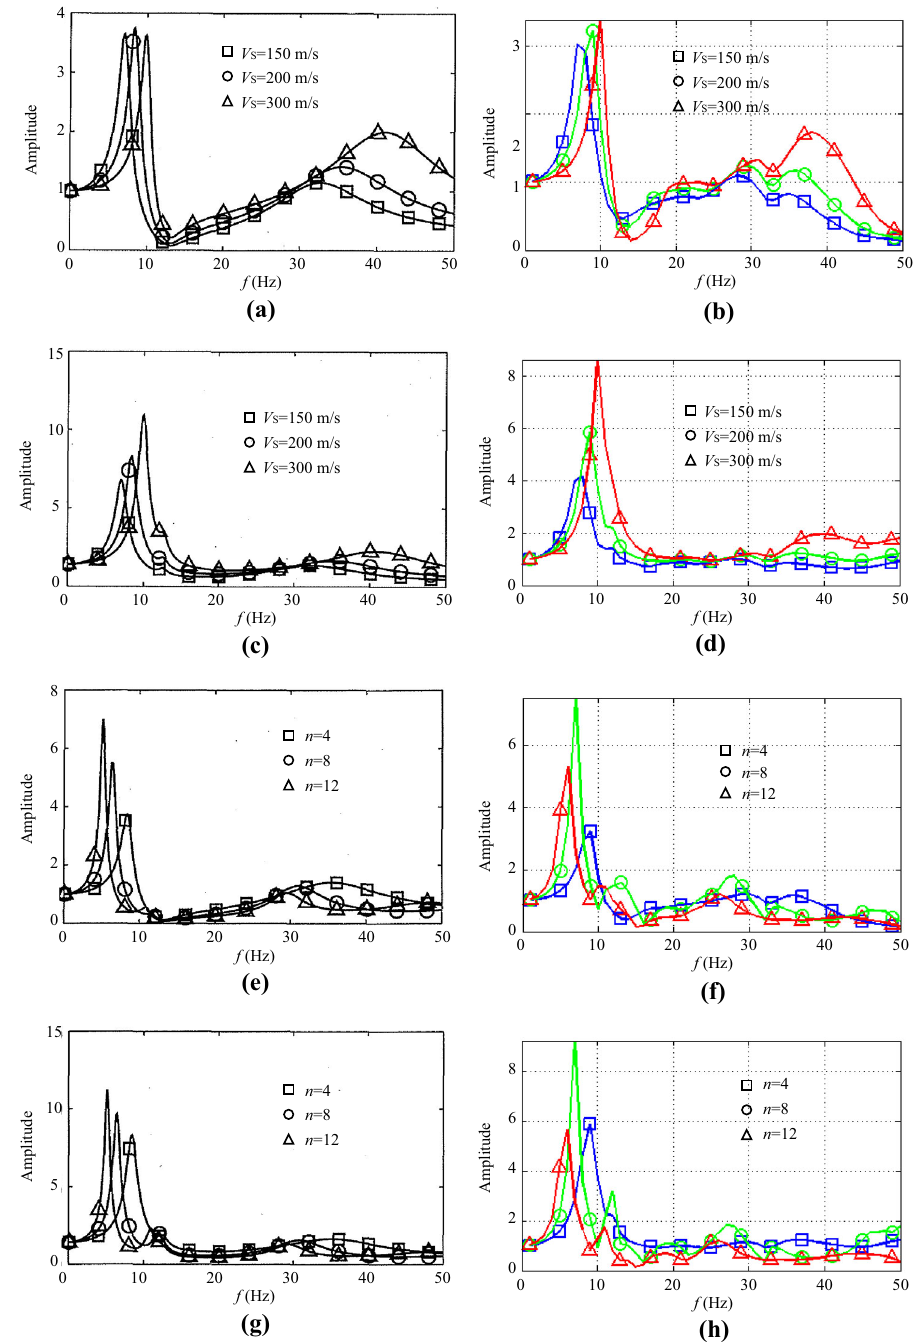
Fig. 14 Averaged soil–column ( a , b , e , f ) and soil–floor ( c , d , g , h ) transfer functions of office buildings with a – d different soils, and with e – h different number of storeys (